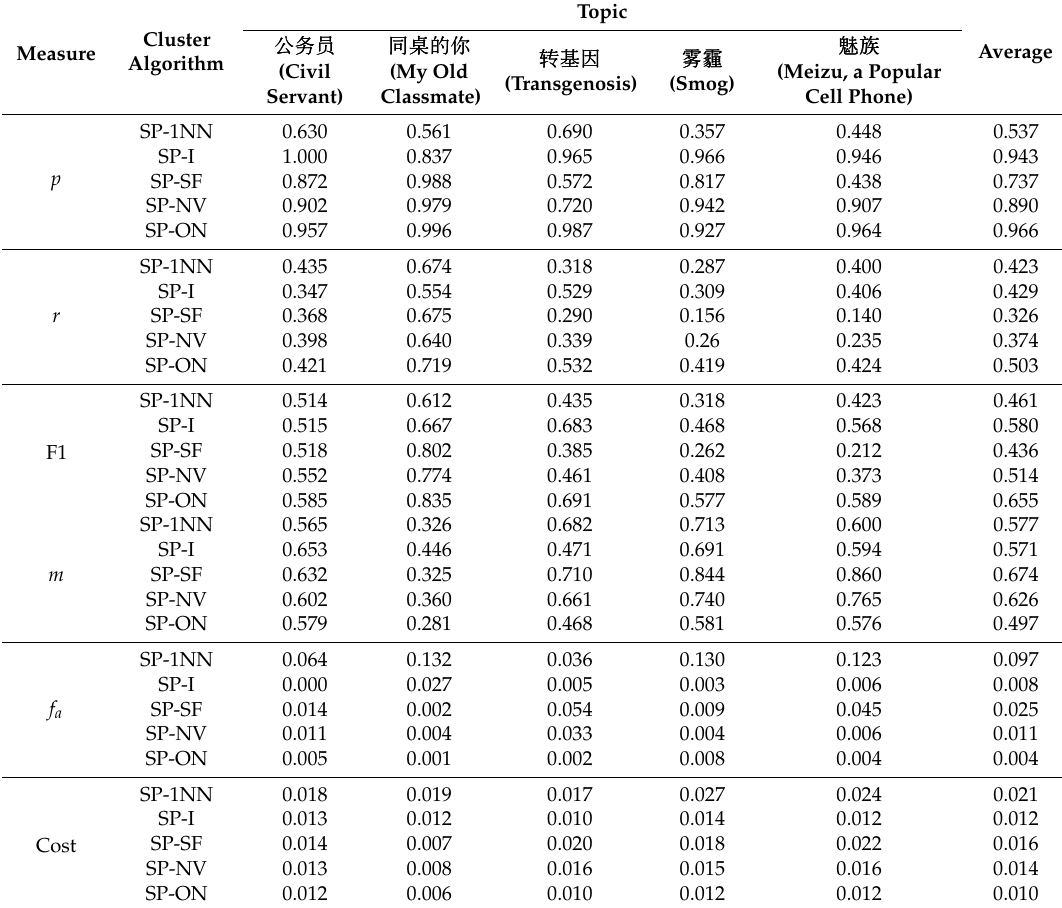
Table 3. The measures of different clustering algorithms on clustered topics when the similarity threshold is